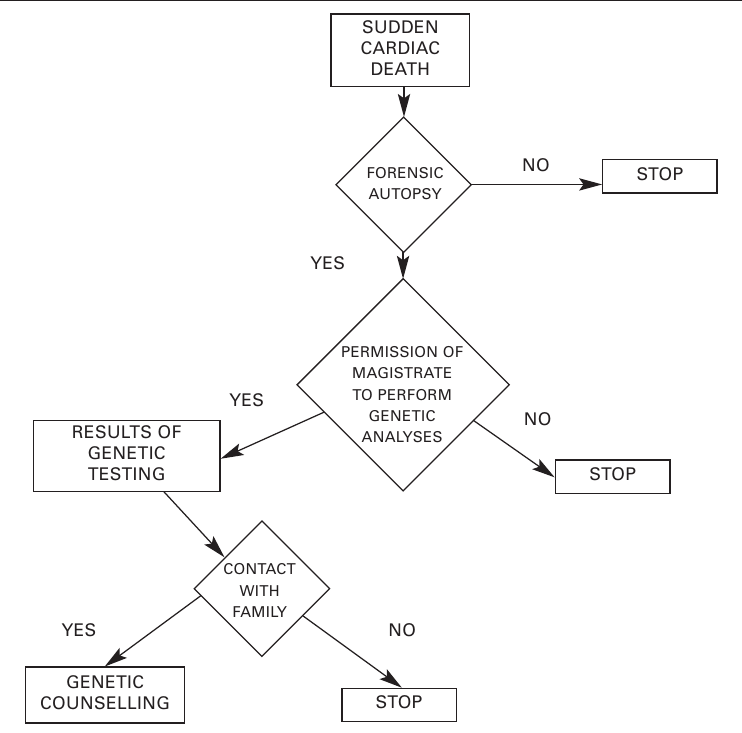
Flow chart of genetic testing in SCD in forensic practice. The genetic analyses in SCD may be performed during the forensic investigation only with the permission of the investigating magistrate.The results of the genetic analyses are transmitted to the investigating magistrate and with his permission to the family. If family members are not contacted or decline to be informed, there is no